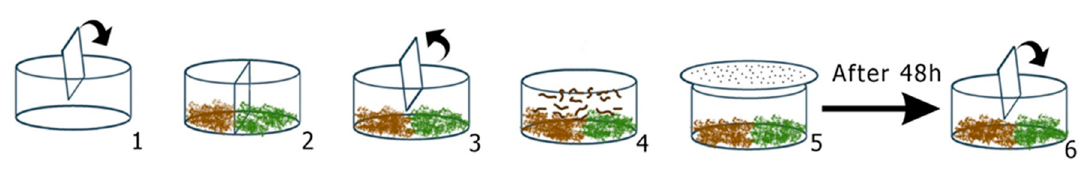
Figure 1. Schematic representation of the experimental procedure of the Enchytraeid avoidance test: ( 1 ) inserting the movable wall into the center of the test vessel; ( 2 ) introduction of the soils to be tested; ( 3 ) the movable wall is removed; ( 4 ) placing the Enchytraeids in the middle of the soil; ( 5 ) covering the test vessel with a lid (perforated); ( 6 ) reintroduce the wall to separate the floors and count the organisms present on each side.